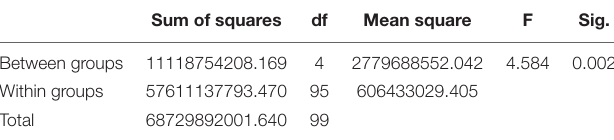
TABLE 5 | Comparison of differences in industrial added value in the five